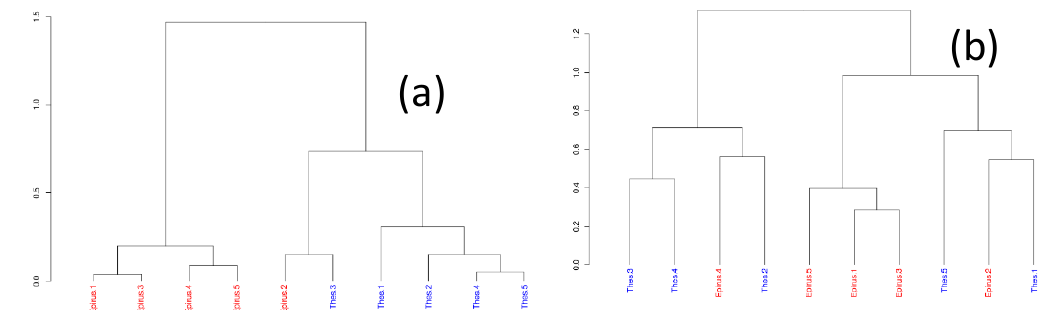
Figure 7. Dendrogram produced from Ward’s clustering according to Bray–Curtis dissimilarity ( a ) with all the species included; ( b ) after the three major species were removed.